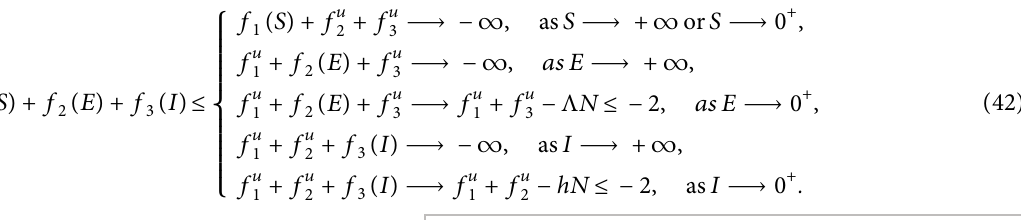
( t ) ,E ( t ) ,I ( t ) is the solution to the deterministic model (1), and S 1 1 1